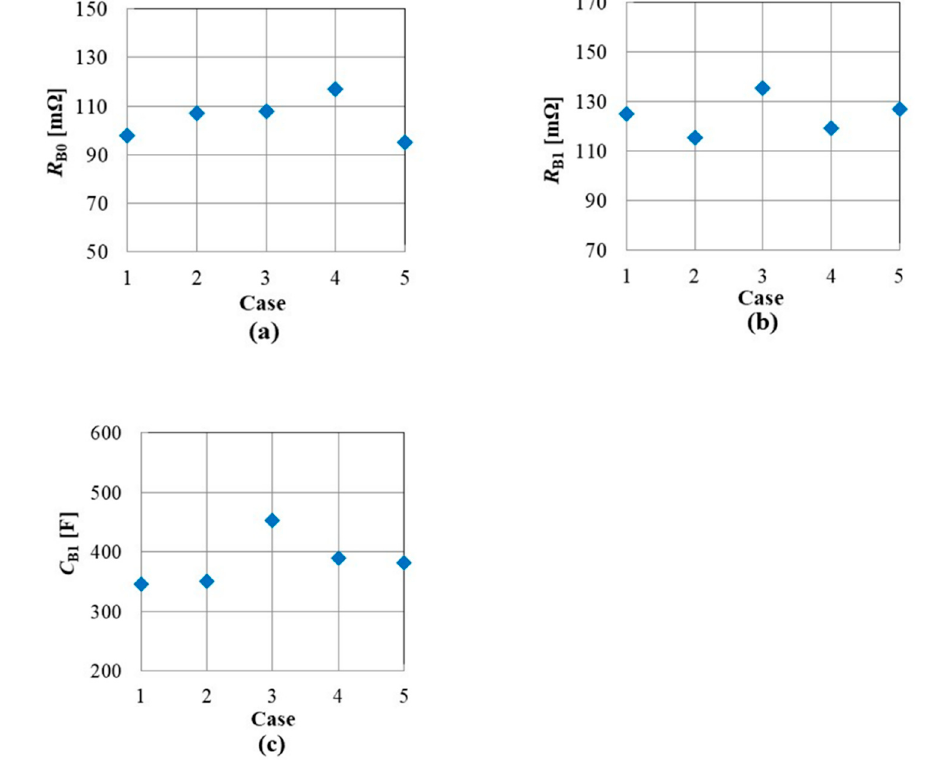
Figure 20. Equivalent circuit parameters obtained by the diagnosis circuit. ( a ) R B0 . ( b ) R B1 . ( c ) C B1 .